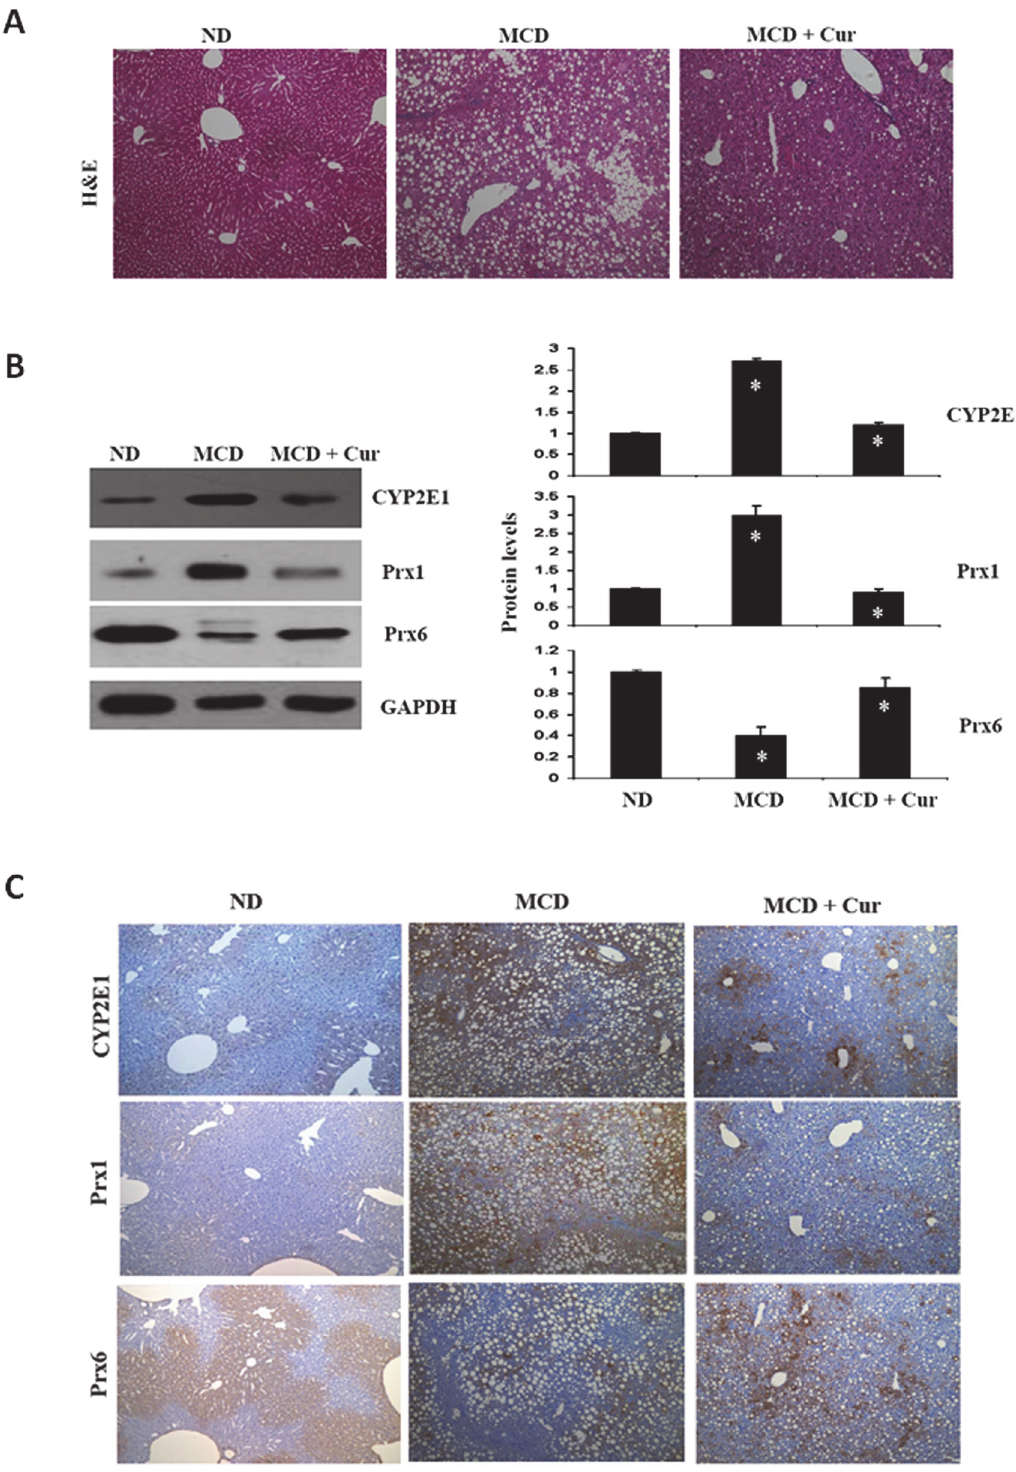
Fig 5. Curcumin prevents oxidative stress and recovers antioxidant protein expression in mice fed MCD. (A) Effect of curcumin on hepatic morphology in mice fed the control diet, the MCD diet and MCD + curcumin diet. The histology of ND and MCD liver sections by Hematoxylin-eosin (H&E) staining (original magnification 200×). (B) and (C) The effect of curcumin on CYP2E1, Prx1, and Prx6 protein levels in curcumin-supplemented diet. CYP2E1, Prx1 and Prx6 protein levels were determined by Western blot and immunohistochemical analysis of livers of mice fed the control or MCD diet alone or MCD + curcumin diet. Data are mean ± SD (n = 6/group). * P < 0.05